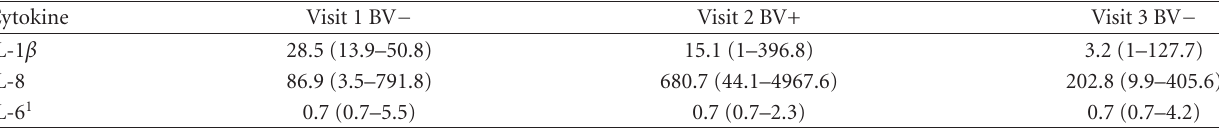
Table 2: Median genital tract concentrations of IL-8, IL-1 β , and IL-6 (pg/ml) at 3 consecutive clinic visits 6 months apart.